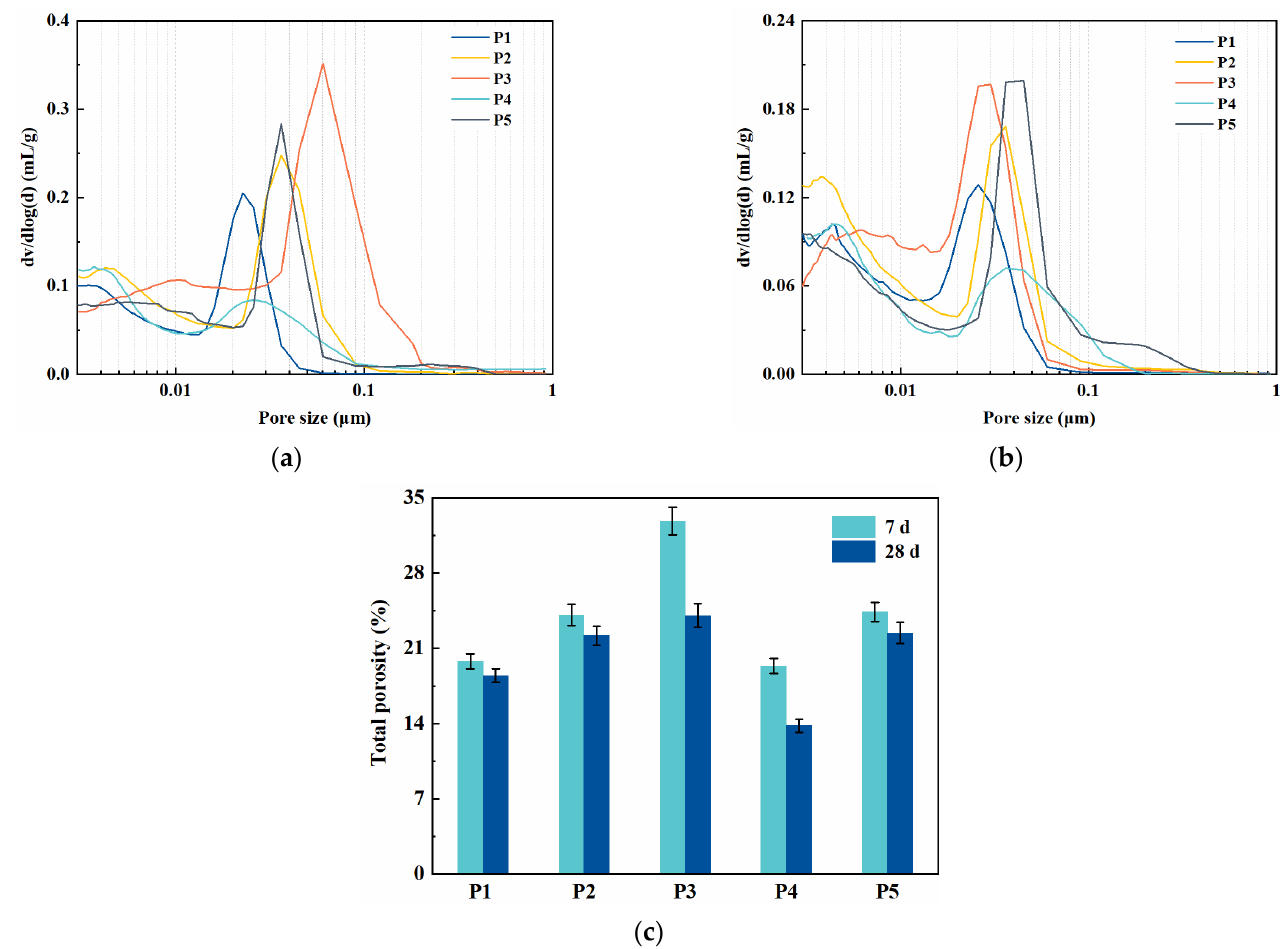
Figure 7. Pore structure of binder pastes: ( a ) pore size distribution, 7 days ( b ) pore size distribution, 28 days ( c ) total porosity.